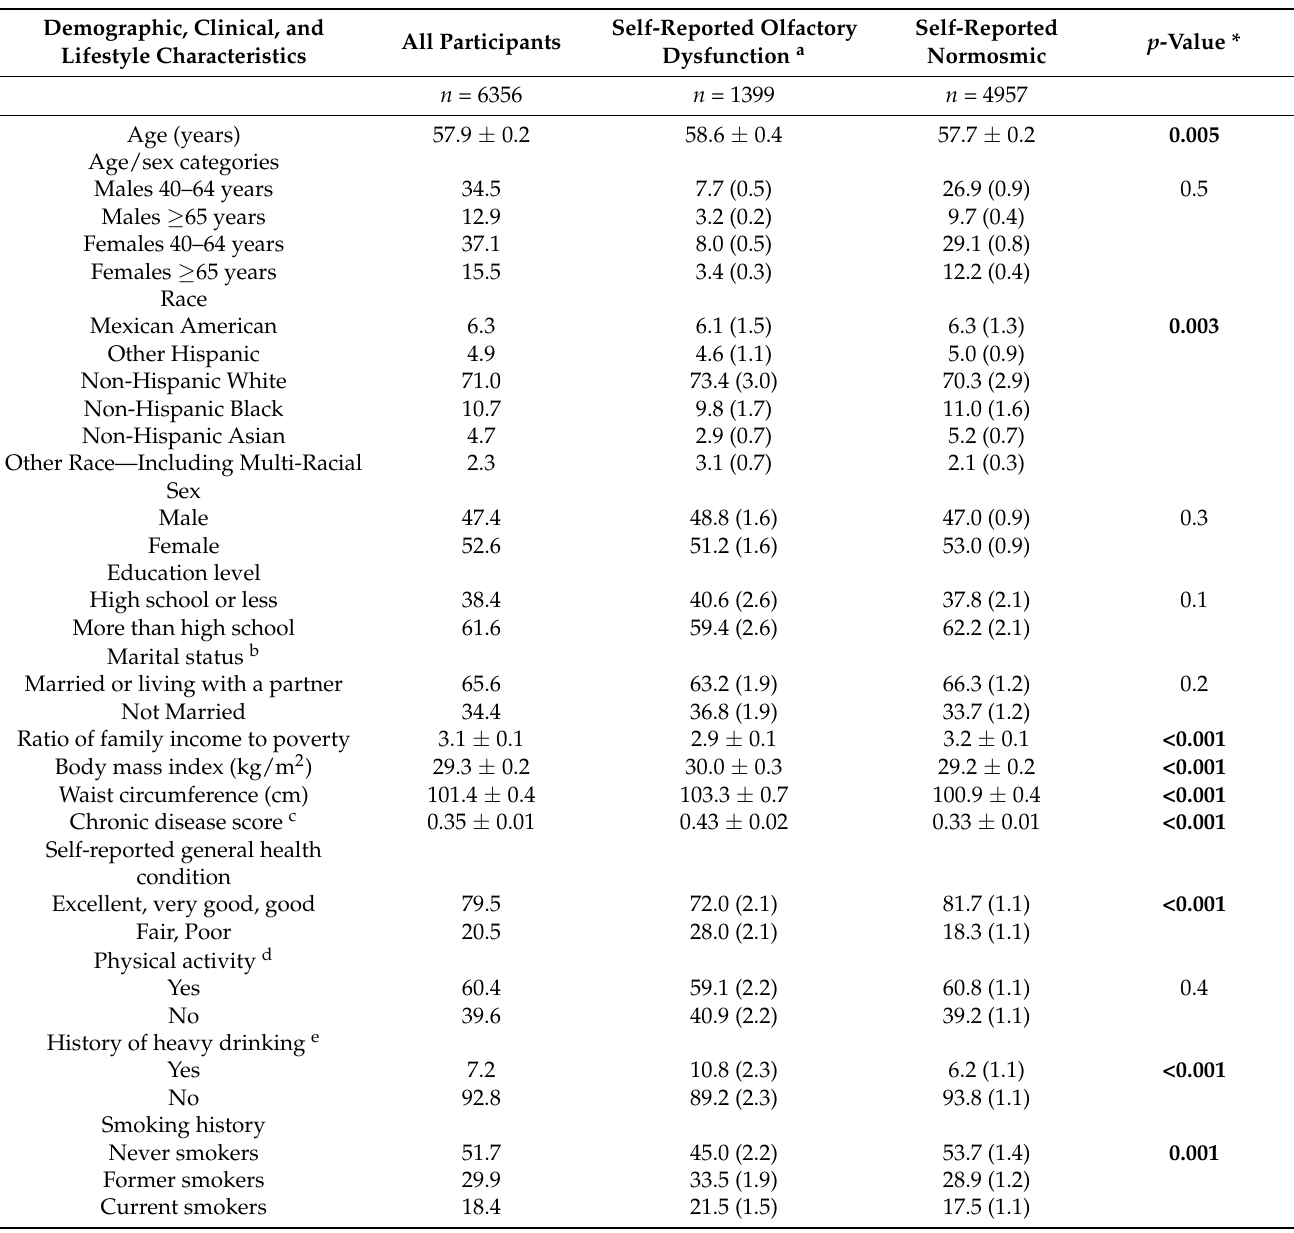
Table 1. Demographic, clinical, and lifestyle characteristics among the 2011–2014 NHANES study participants, ages 40 years and older